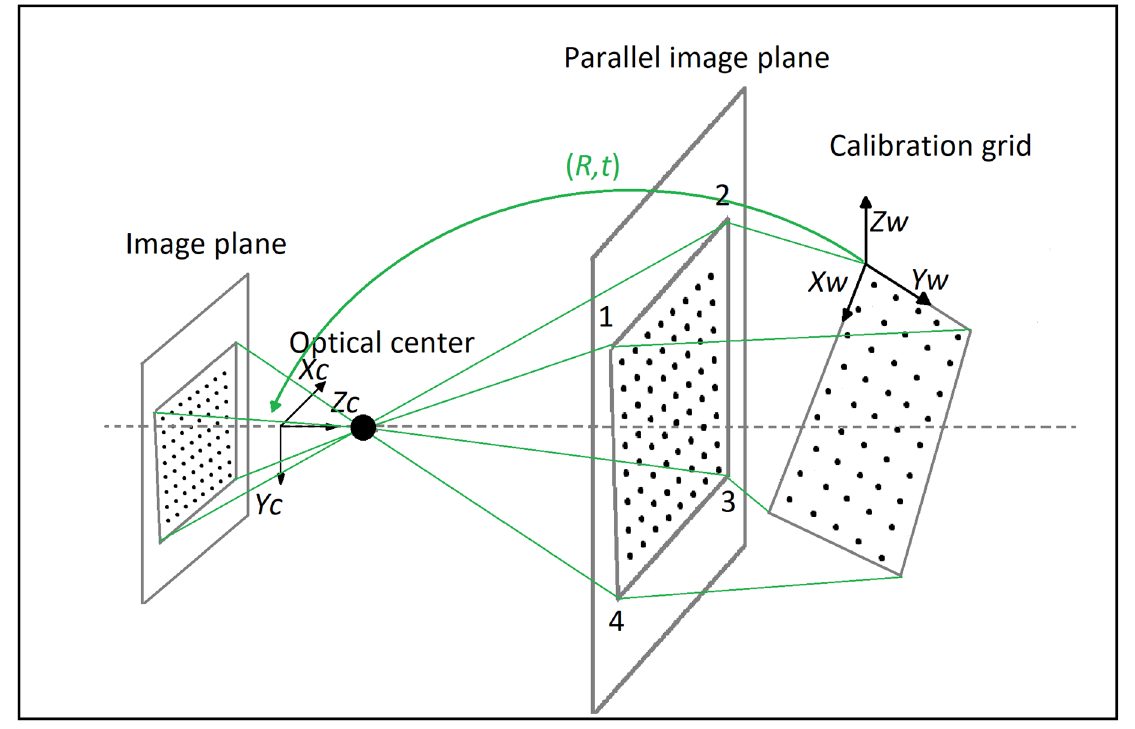
Figure 5. Projective mapping